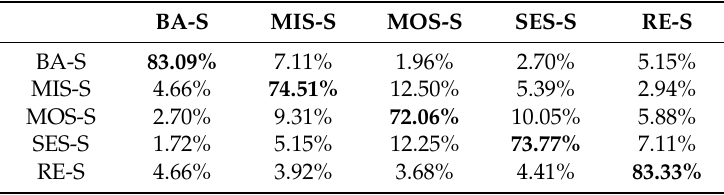
Table 5. Classification rates of K-ELM with SKT features (SKT + K-ELM).